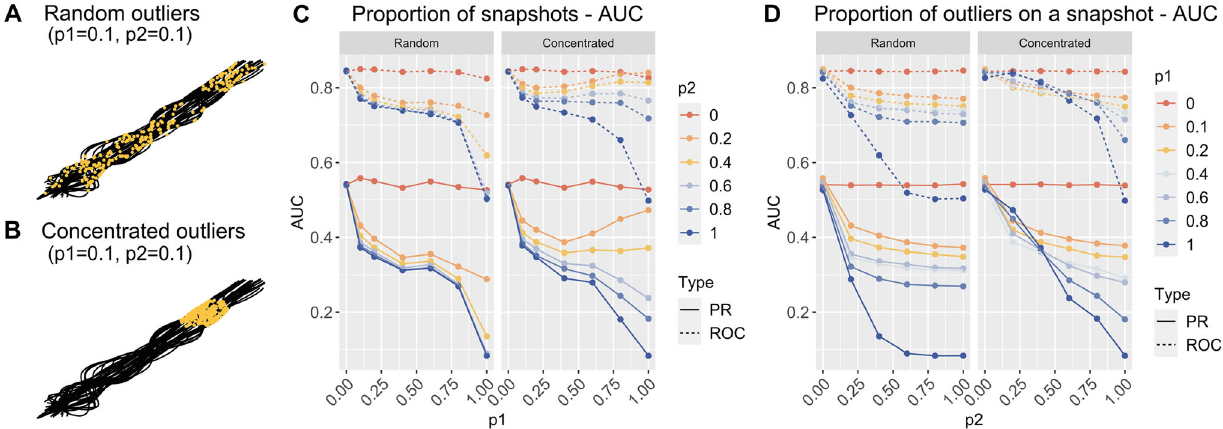
Fig.4 Outliers and the influence towards K-similaritymeasurement. A Locations of concentrated outliers, B locations of random outliers, C outliers test with respect to the proportion of snapshots, D outliers test with respect to the proportion of outliers on a